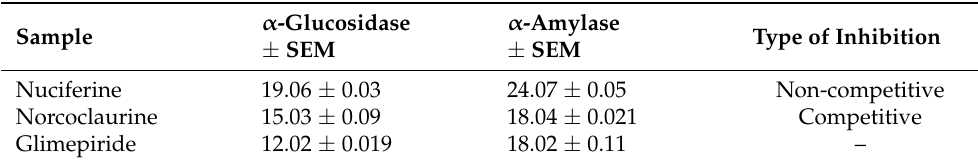
Table 6. The α -Glucosidase and α -Amylase Inhibitory Activities of Nuciferine and Norcoclaurine (IC 50 , µ M).